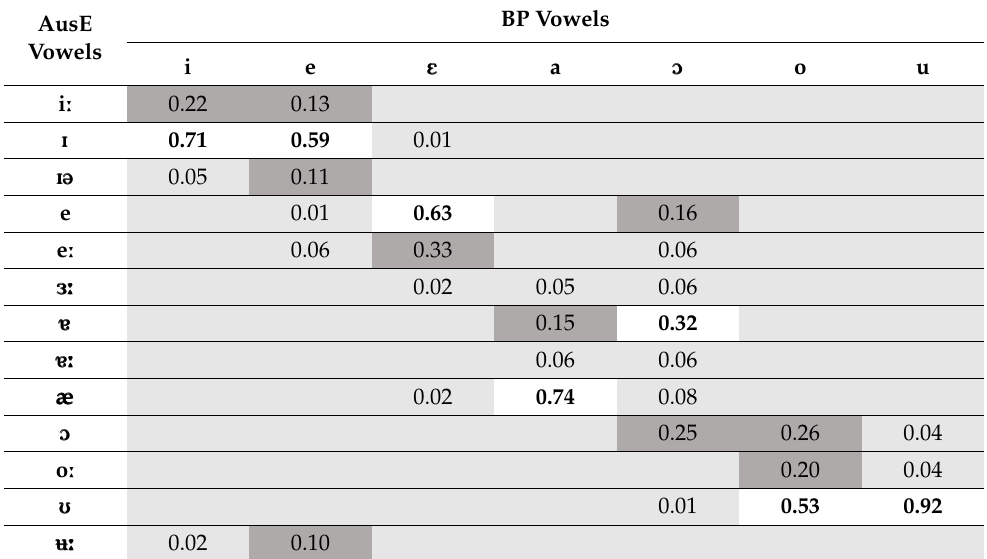
Table 1. Average probability scores of predicted group membership for male and female BP tokens tested on each individual AusE listener model. Probabilities are averaged across the individual discriminant analysis for each speaker. The native vowel category with the highest probability appears in a cell in bold, with no shading, probabilities above chance appear in cells shaded dark grey and probabilities below chance (i.e., 0.08) appear in cells shaded light grey.